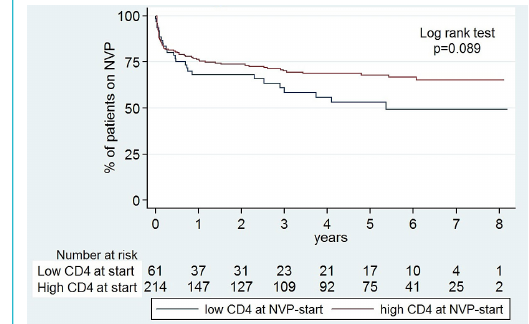
Figure 2: Kaplan-Meier survival curves: probability of remaining on nevirapine (NVP) in high-high-undetectable patients versus low-high-undetectable patients. “Low/high-low/high-detectable/un- detectable” refers to “(CD4 nadir)–(CD4 at NVP start)–(HIV-RNA